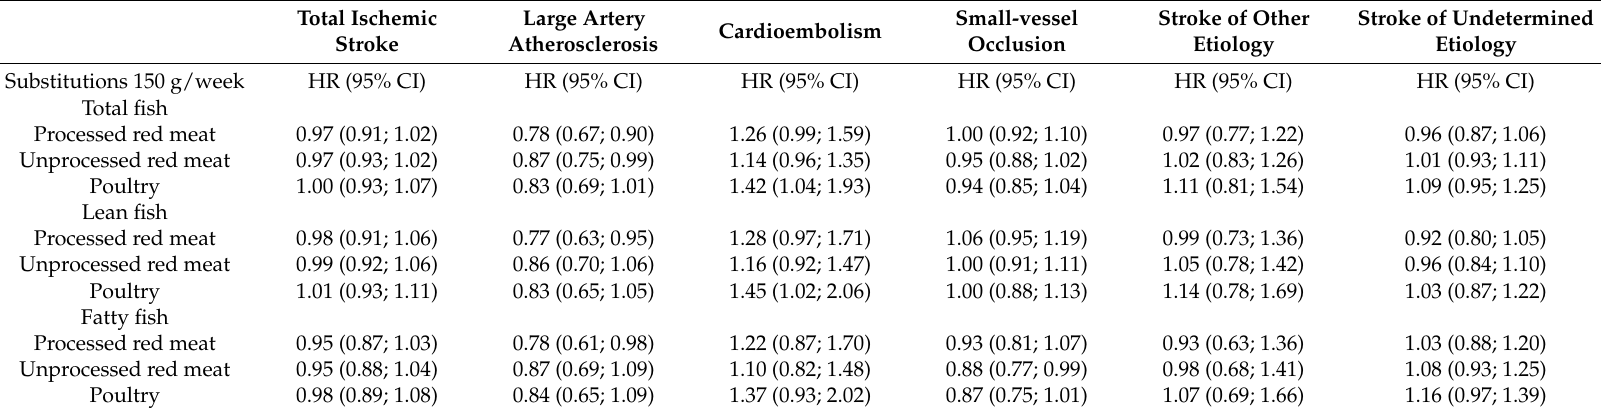
Table 2. The association between substitution of fish for processed red meat, unprocessed red meat or poultry and total ischemic stroke and ischemic stroke subtypes. Total